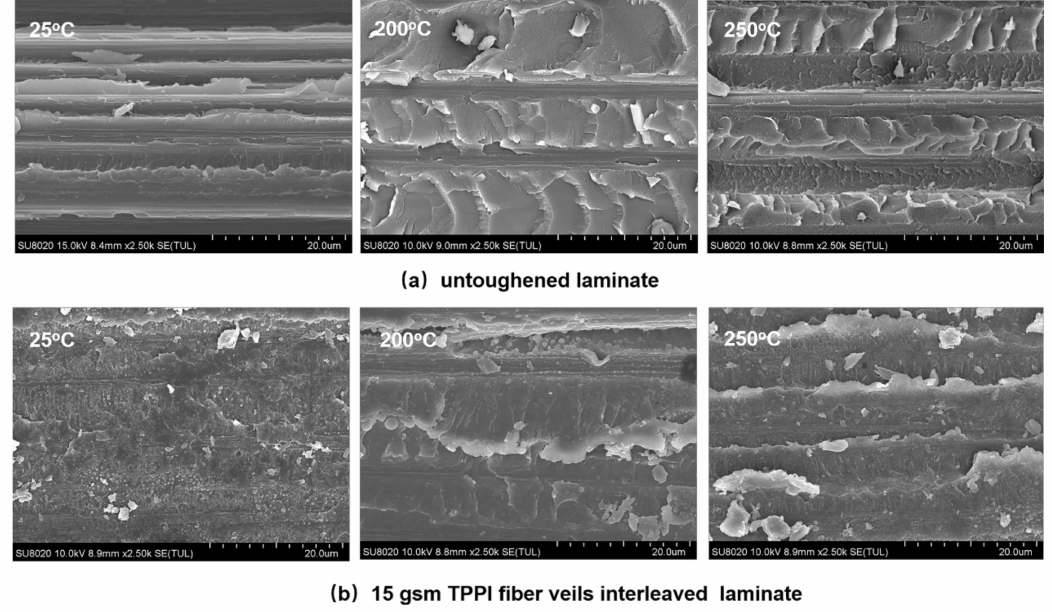
Figure 10. SEM micrographs of mode I fracture surfaces for untoughened and interleaved laminates after DCB test at different temperature. ( a ) untoughened laminate; ( b ) 15 gsm TPPI fiber veils interleaved